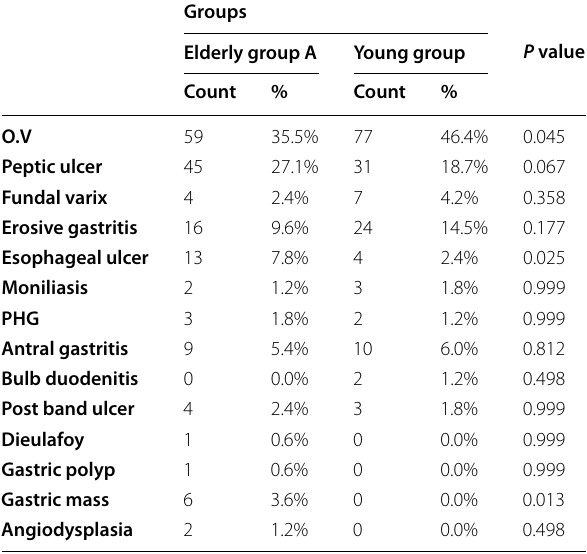
O.V esophageal varices, PHG portal hypertensive gastropathy